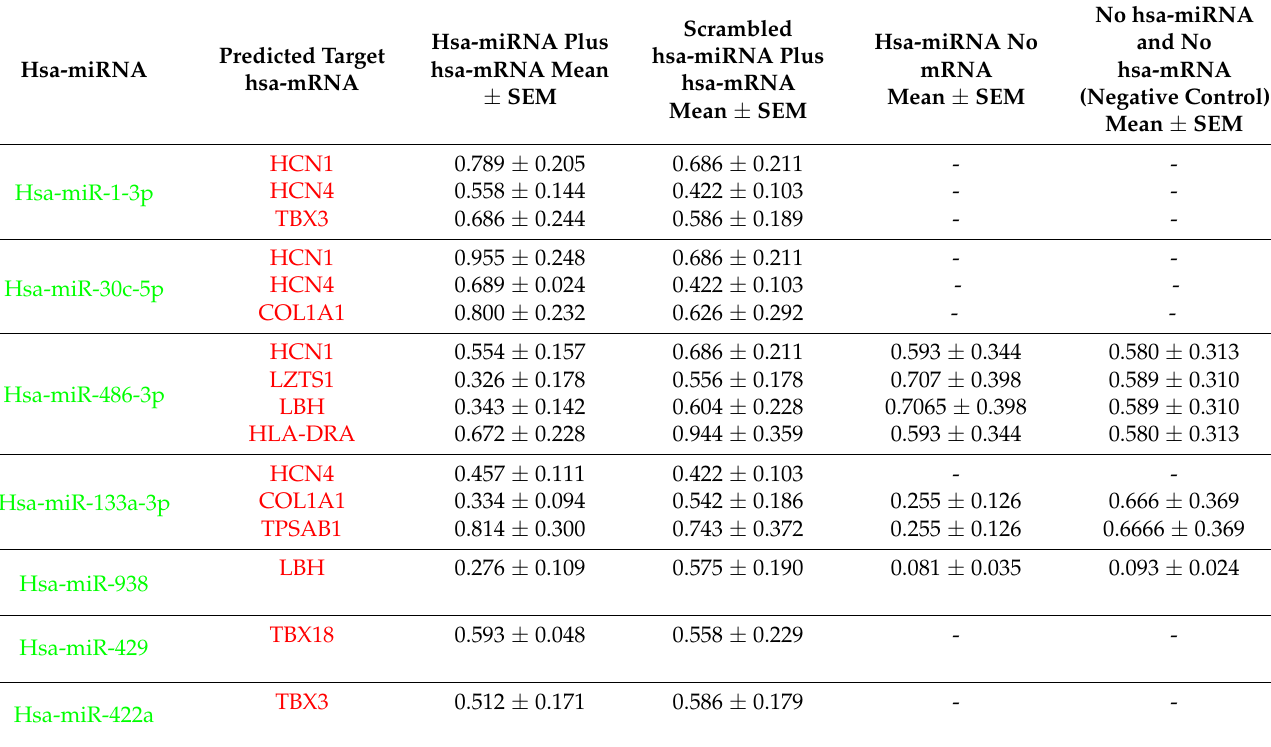
Table 2. Nonsignificant downregulation of hsa-mRNAs by hsa-miRNAs in H9C2 cells, observed following luciferase assay experiments. Mean ± SEM values are shown. Red represents significantly more expressed mRNA in the SN vs. right atrium whereas green represents significantly less expressed microRNA in the SN vs. right atrium, as shown in our previous publications